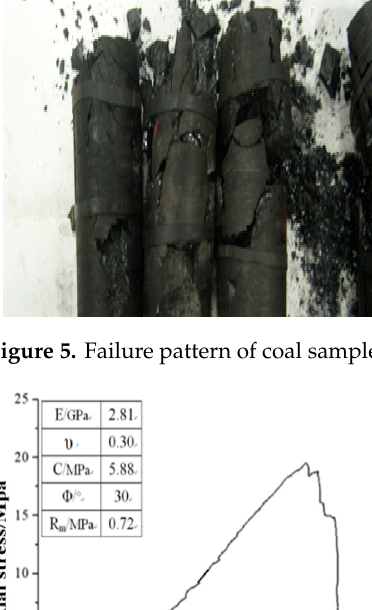
Figure 5. Failure pattern of coal samples.